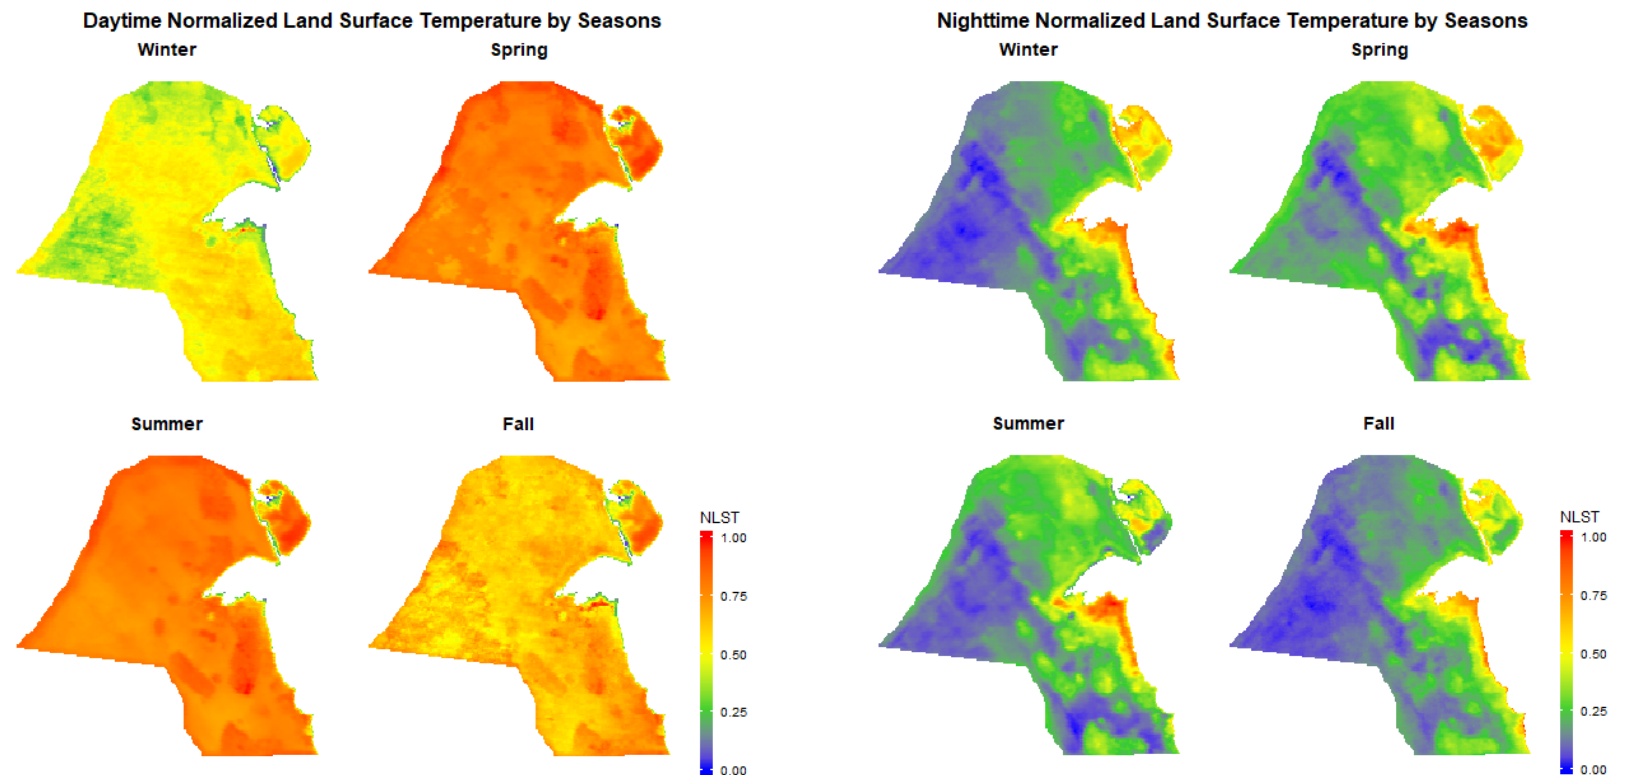
Figure 3. Average daytime and nighttime normalized land surface temperature (NLST) stratified by seasons in Kuwait (2001–2017).